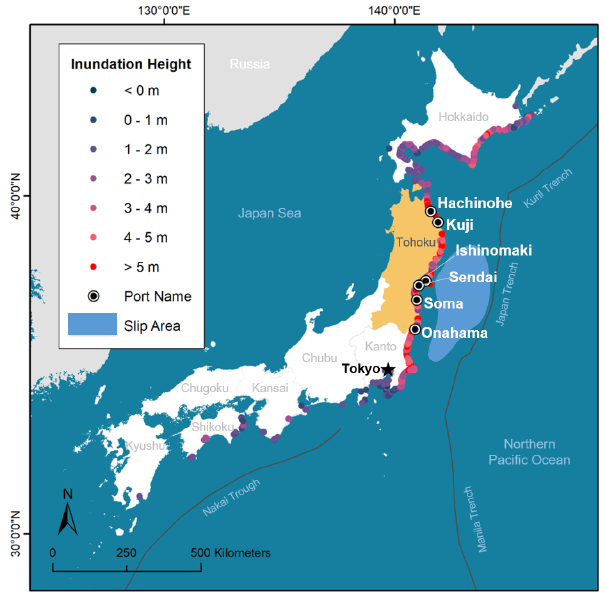
Figure 1. Six of the affected ports (circled dots) were selected in this study due to similarities in their coastal morphologies – they are located in coastal plains. Tsunami inundation heights were mea- sured and collected by the Tohoku Earthquake Tsunami Joint Sur- vey (TTJS, 2011) team. Inundation heights refer to the maximum height of tsunami inundation above the mean sea level in Tokyo Bay (the Tokyo Peil datum). The generalised 2011 fault-rupture area (in light blue) was inferred from GPS data adapted from Ozawa et al.